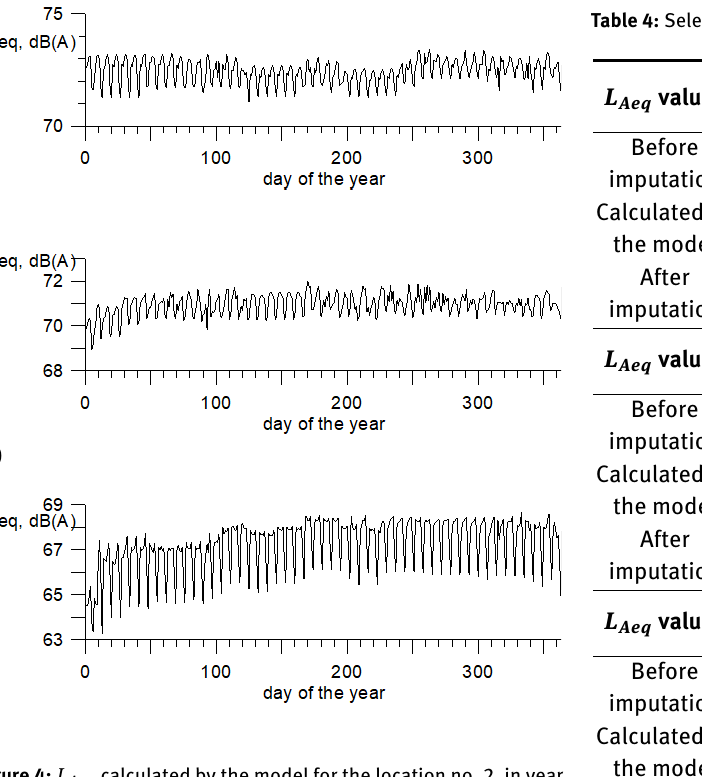
Figure 4: L Aeq calculated by the model for the location no. 2, in year 2013, for: (a) day sub-interval (6-18), (b) evening (18-22), and (c) night (22-6) in year 2013